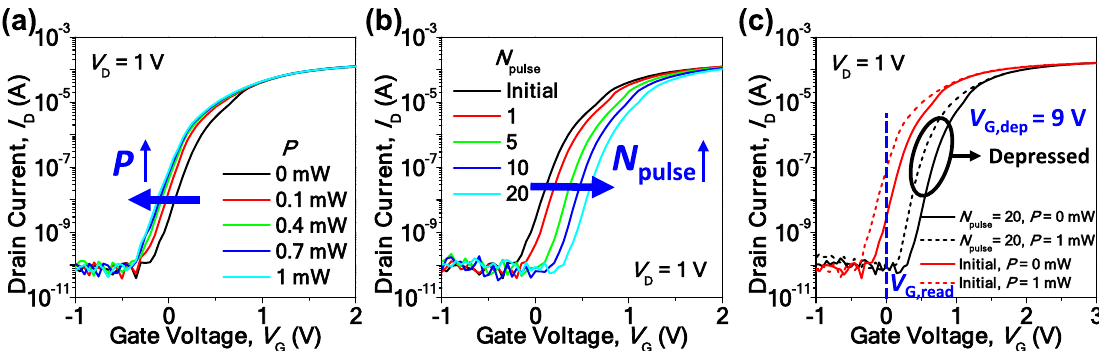
Figure 2. ( a ) Transfer characteristics ( I D – V G ) of the MOST for various light intensities ( P ). Leftward V T shift with increased P that corresponds to a temporal response by the photo-carrier density. ( b ) I D – V G for various N pulse with + V G . Rightward V T shift with increased N pulse that corresponds to a semi-permanent response by the trapped electron density. This is a depression operation for reducing the weight of the synaptic device. ( c ) I D – V G at dark and 1 mW light illumination before and after depression. Photocurrent ( I photo ) at read gate voltage ( V G,read ) of 0 V is approximately 0.1 μA before the depression and 0.1 nA after the depression, respectively. In this way, the trapped electron density tunes the